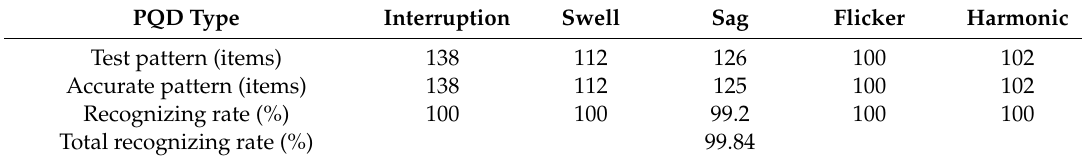
Table 1. The classification and recognizing results of power quality disturbance.